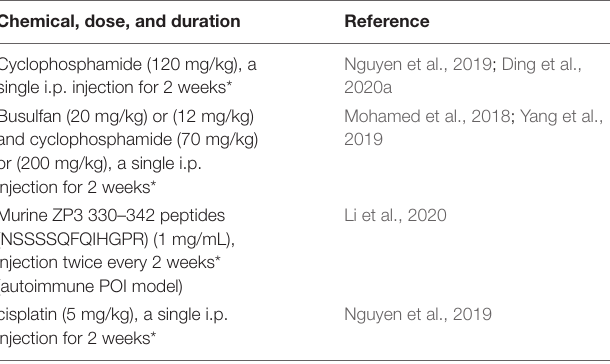
TABLE 5 | Chemical and peptide-induced animal model of POI. Chemical, dose, and duration